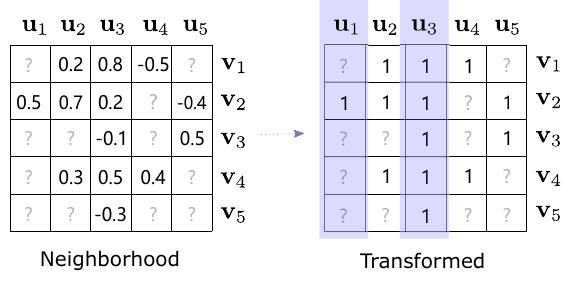
Figure 3. illustrates one neighborhood of the input